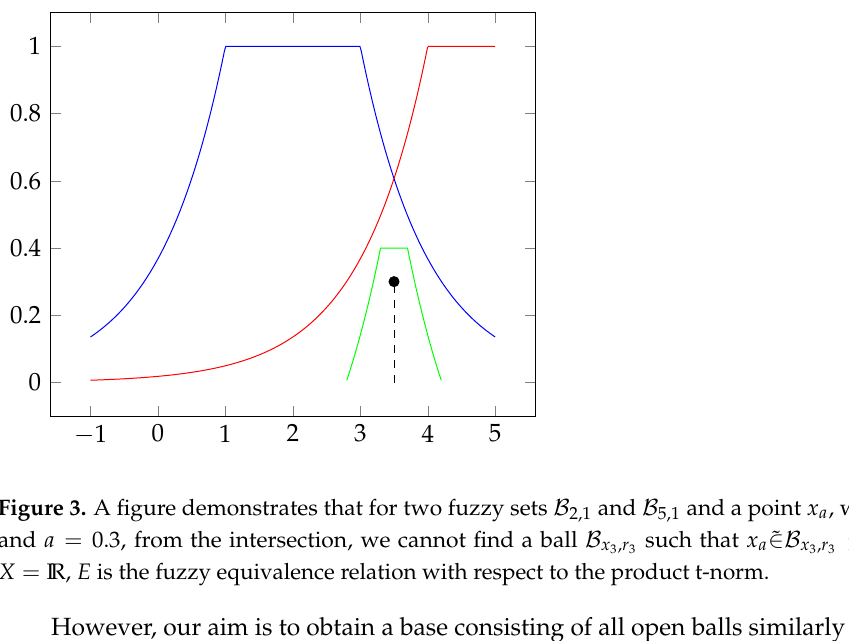
≤ B ∧ B such that x a ˜ ∈B x 2,1 5,1 . 3 , r 3 3 , r 3